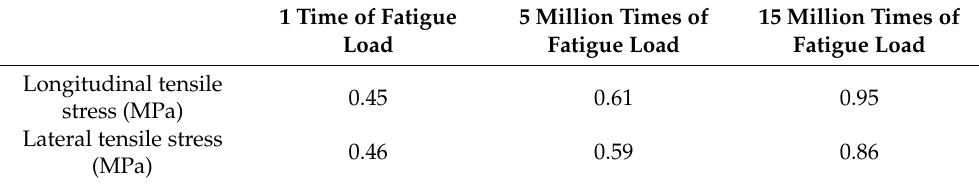
Figure 22. Stress distribution diagram of the base plate under fatigue load of 12 million applications (working condition 3). ( a ) Longitudinal stress of base plate; ( b ) lateral stress of base plate.